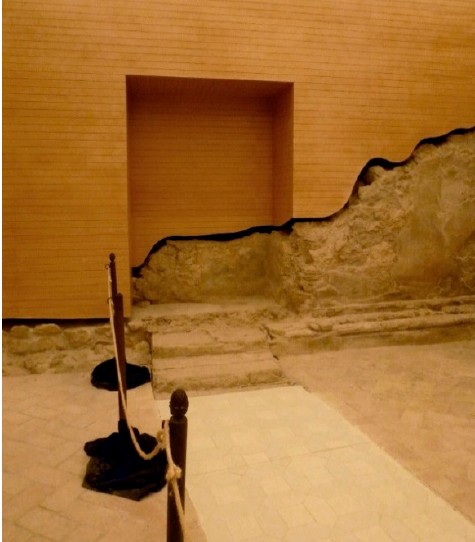
Figure 11. The heikhal of Lorca Synagogue. Author’s photo.